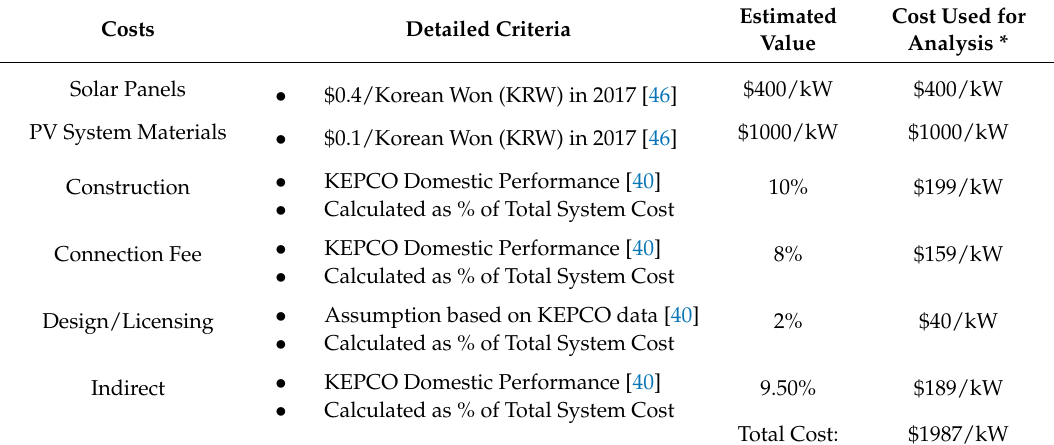
Table 2. Initial investment costs.